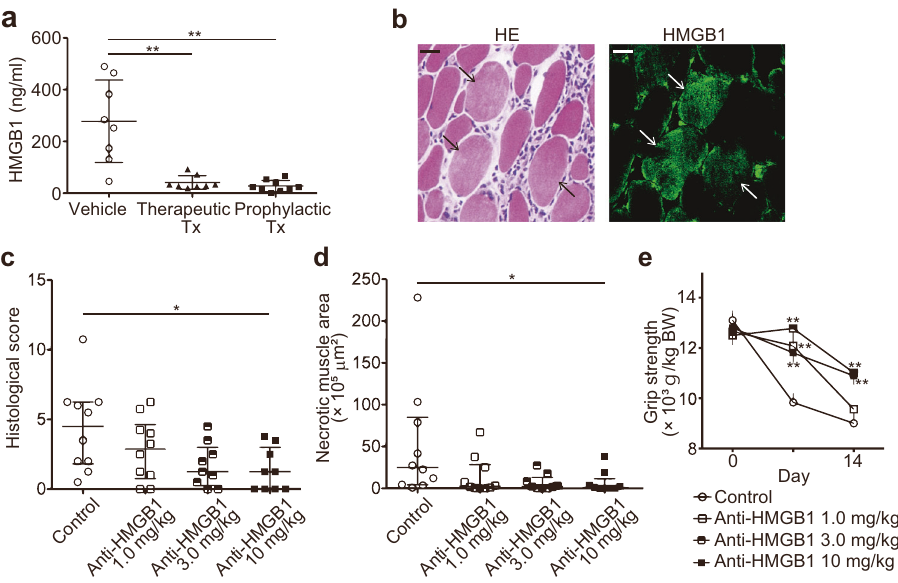
Fig. 6 The involvement of HMGB1 in the muscle in fl ammation and muscle weakness in CIM. a The serum levels of HMGB1 in CIM mice on day 21. The data are presented as mean ± SD. One-way ANOVA test, followed by Dunnett ’ s test. ** p < 0.01. b HE and immuno fl uorescence staining of the muscle specimens of CIM for the expression of HMGB1. The arrows indicate the dying muscle fi bers. Scale bars indicate 20 μ m. c The histological scores on day 14 in CIM mice treated with 1.0 mg/kg ( n = 10), 3.0 mg/kg ( n = 9), or 10 mg/kg ( n = 9) of anti-HMGB1 antibodies (anti-HMGB1) or 10 mg/kg of the control antibodies (Control: n = 10). The data are presented as median ± interquartile. Kruskal – Wallis test, followed by Dunn ’ s test. * p < 0.05. d The areas of necrotic muscle fi bers on day 14 of CIM. Data are presented as median ± interquartile range. Kruskal – Wallis test, followed by Dunn ’ s test. * p < 0.05. e The gri p strength of CIM mice treated with anti-HMGB1 antibodies or the control antibodies. Data are presented as mean ± SD. Two-way ANOVA test, followed by Dunnett ’ s test. ** p < 0.01. c – e Data represent two independent